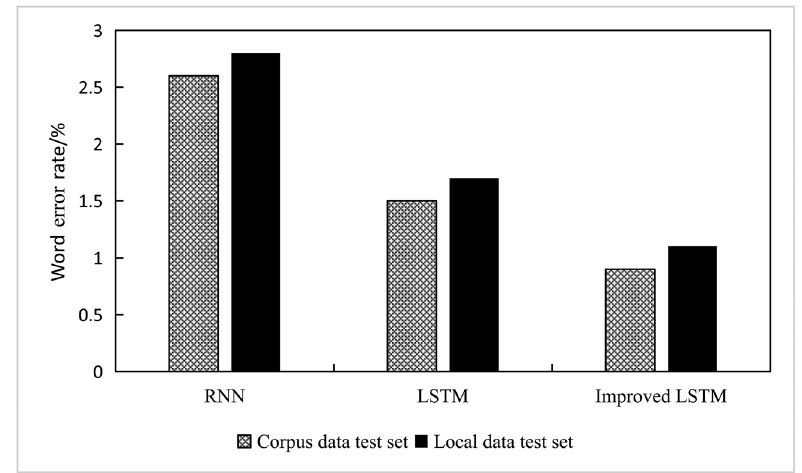
Figure 3: Word error rates of three machine translation algorithms for translating the corpus data test set and local data test